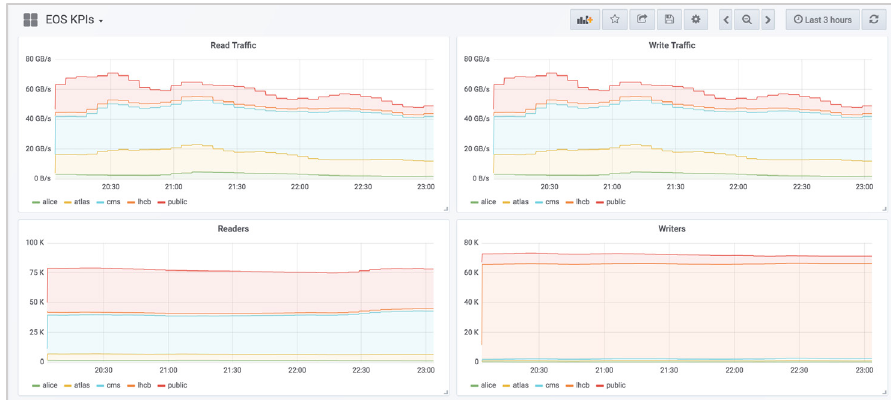
Fig. 4. Example of Dashboard of EOS Storage